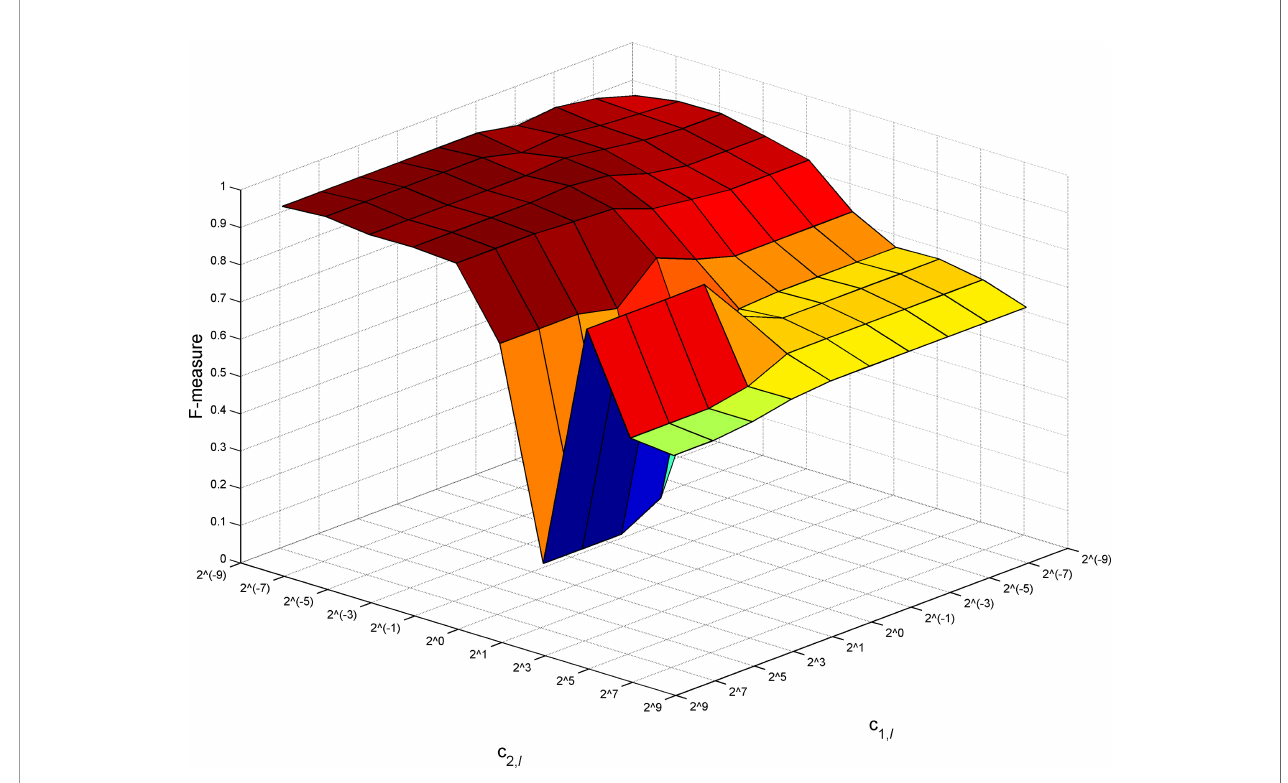
FIGURE 6 | Variations in F-measure with regularization hyperparameters for IR=100:80.